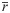
Average representation r¯ of the higher-, middle- and lower-income classes over the 929 CBSA as a function of the local density of households.On average, we find that low-density regions (the suburbs) are on the richer end, while high density regions (the center) are on the poorer end. This confirms on a large dataset a stylized fact that had previously emerged from local studies. Interestingly, we also find that high income households are on average overrepresented in very large density areas (ρ > 20,000/km2), suggesting that density may be one relevant factor in the explanation of the differences between neighbourhoods.